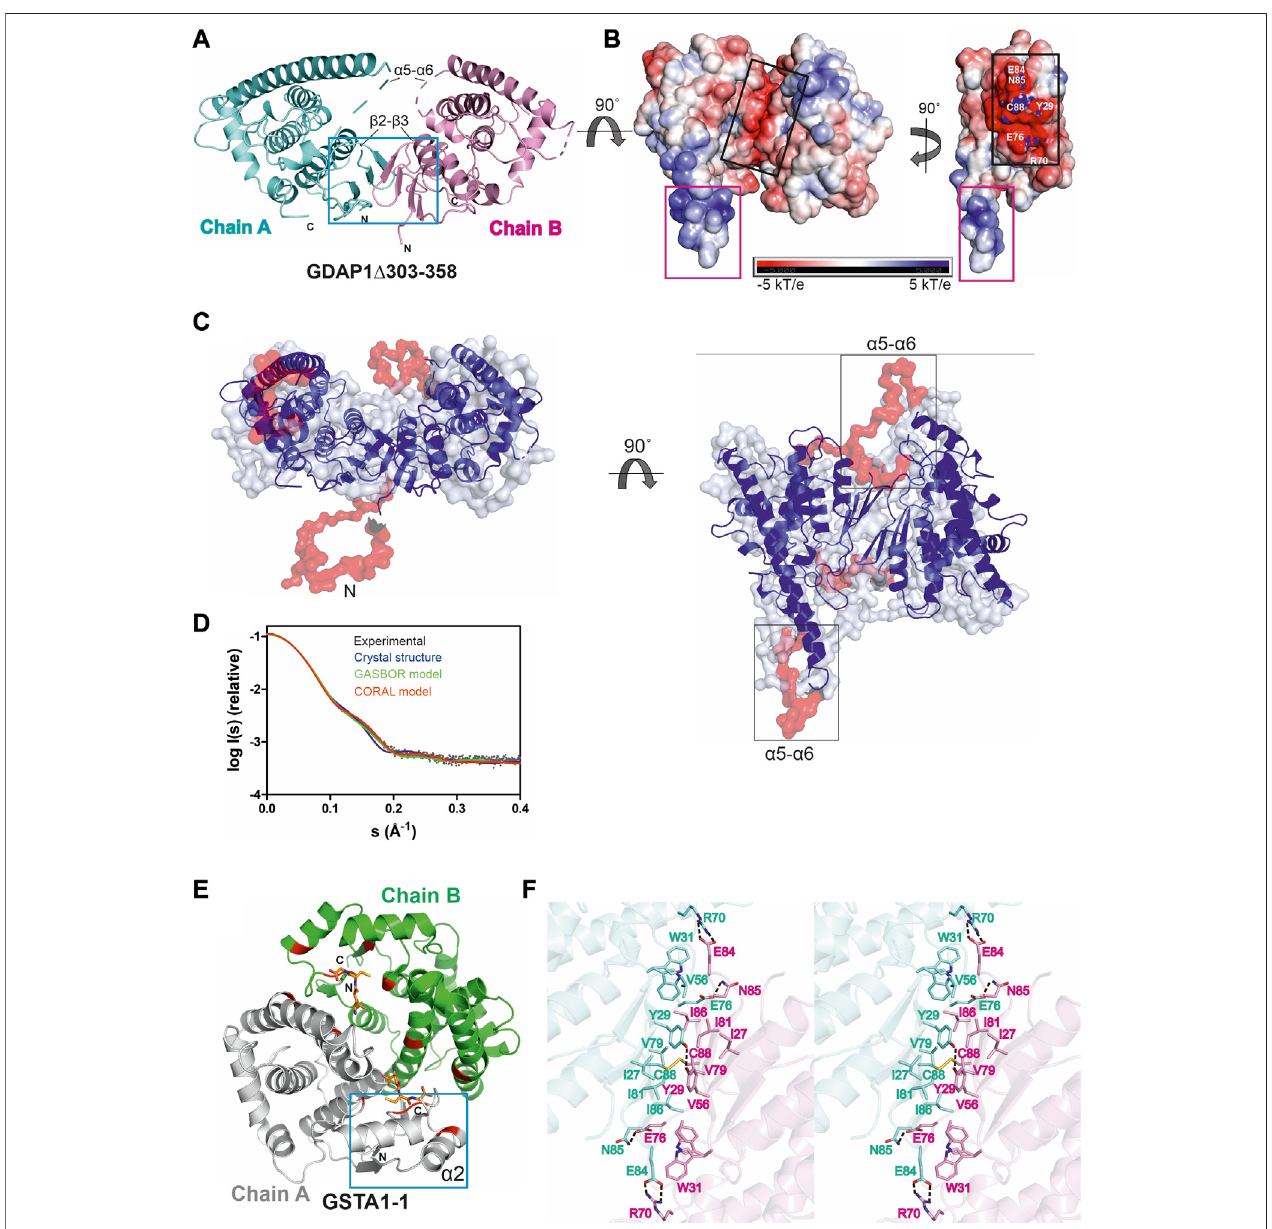
FIGURE 4 | Crystal structure of the complete GDAP1 core domain and the dimer interface of GDAP1 compared to GSTA1-1. The orientation of GDAP1 chain A (cyan)andGSTA1-1chainA(grey)arethesame. (A) OverallstructureofthedimericGDAP1 Δ 303-358.ChainAandchainBareshownincyanandpink,respectively.The dashed lines indicate loops not de fi ned by electron density. The dimerization interface is highlighted with a blue box. (B) Electrostatic surface potential of GDAP1 Δ 303- 358 is presented. The rotation shows only chain A. Note the strong positive potential of the long helix α 6 (magenta box) and the negative potential of the dimer interface (black box). (C) Two different views of the ab initio chain-like model of dimeric GDAP1 Δ 303-358 (transparent surface) superimposed with the GDAP1 crystal structure(blue)andthehybridmodel.Thebuiltregionsnotpresentinthecrystalstructureareshowninred. (D) Experimental scatteringcurveofGDAP1 Δ 303-358dimer (black) overlaid with the theoretical scattering curve calculated from GDAP1 Δ 303-358 structure (blue, χ 2 (cid:2) 17.1), GASBOR model (green, χ 2 (cid:2) 38.2) and CORAL model (red, χ 2 (cid:2) 4.7) using CRYSOL. (E) Dimeric GSTA1-1 (Grahnet al., 2006).GSH isshown asorange sticks. Thecatalytic residues are shown in red.Blue box istheGST-N region corresponding to GDAP1 dimer interface. Chain A and chain B are shown in grey and green, respectively. (F) Stereo view of the dimer interface showing interacting residues. The disul fi de bond is shown, and hydrogen bonds are indicated by dashed lines.